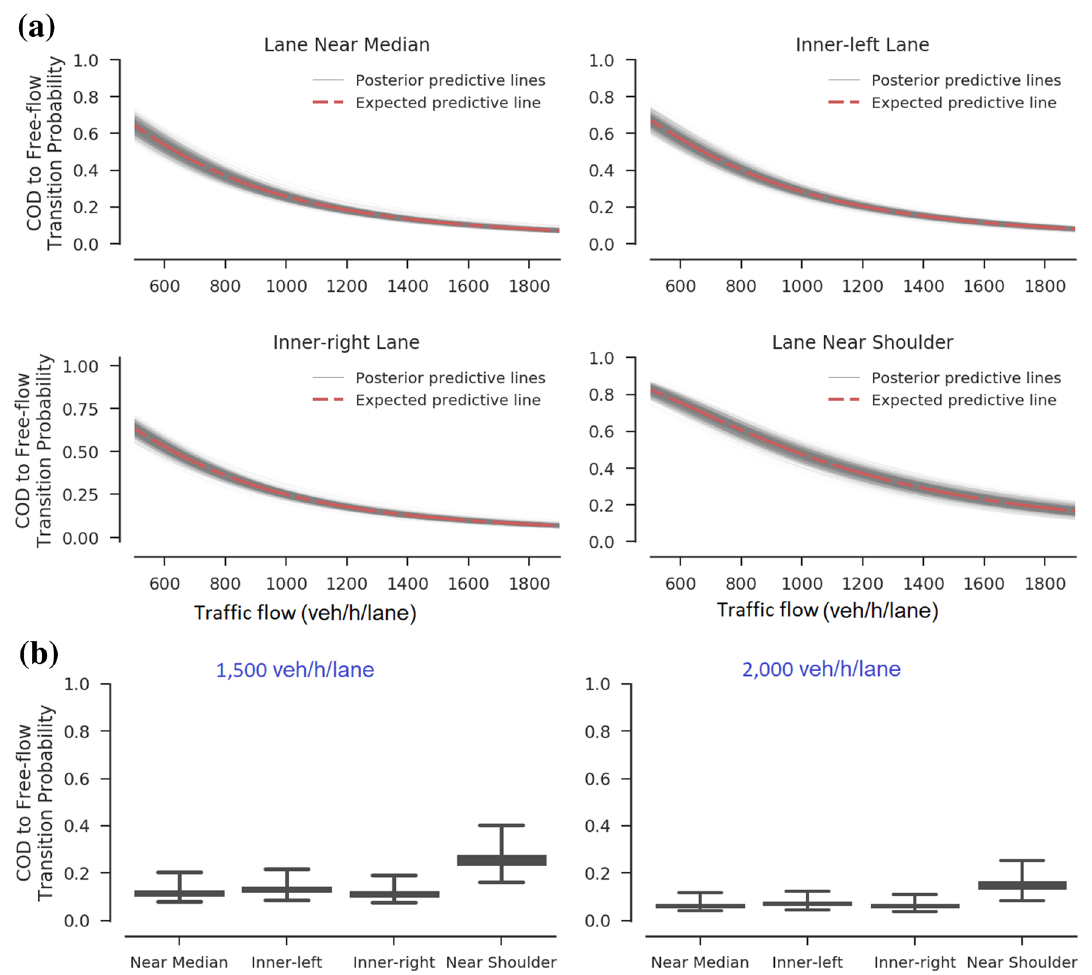
Fig. 7 Transition probability and flow rate relationship for Site 2. a COD to free-flow transition probability versus flow rate. b COD to free-flow transition probabilities across lanes at different flow